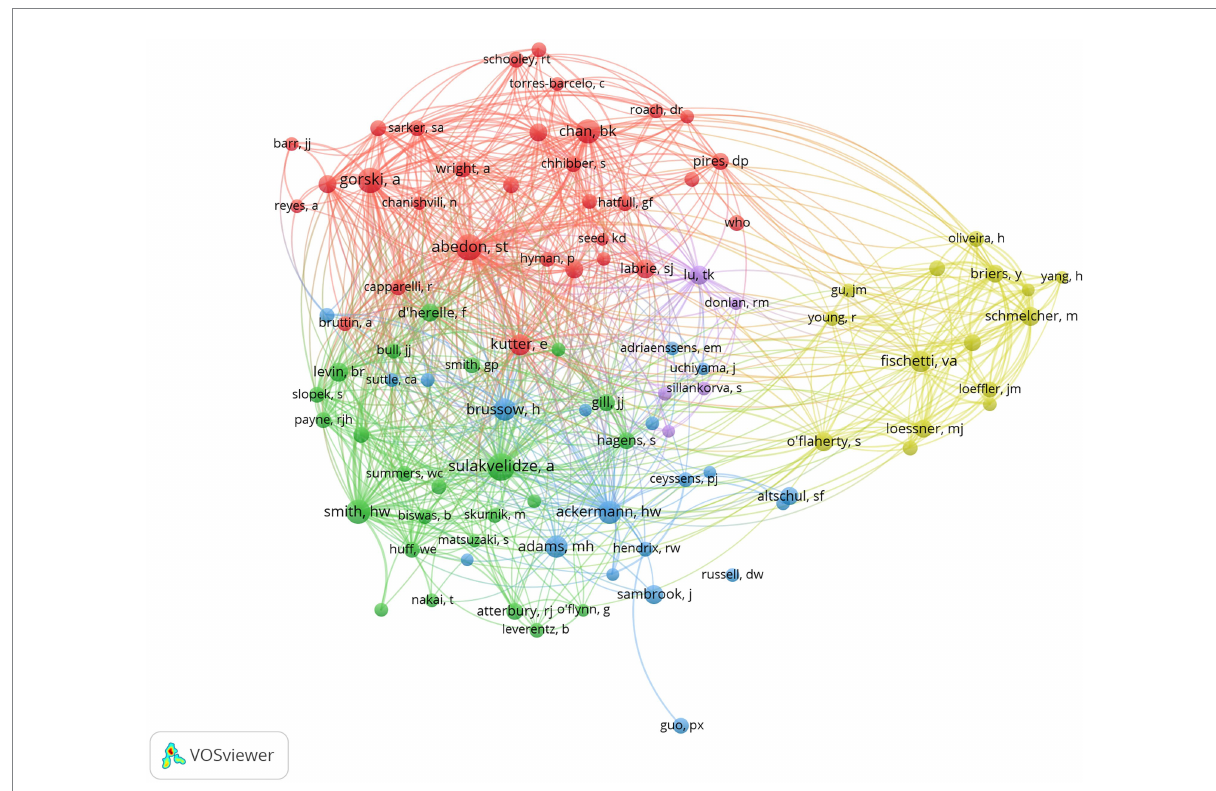
FIGURE 6 Top 100 most productive authors in the field (T ≥